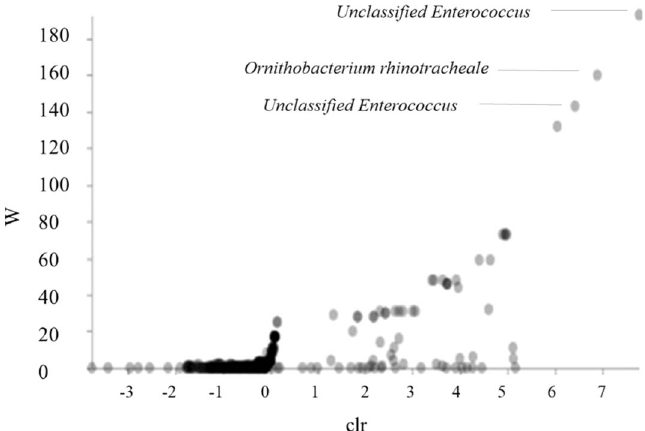
Figure 6. ANCOM Volcano Plot. In the ANCOM analysis the W value represents the number of times of the null-hypothesis (the average abundance of a given species in a group is equal to that in the other group), it was rejected for a given species. The clr (axe x) is the central log